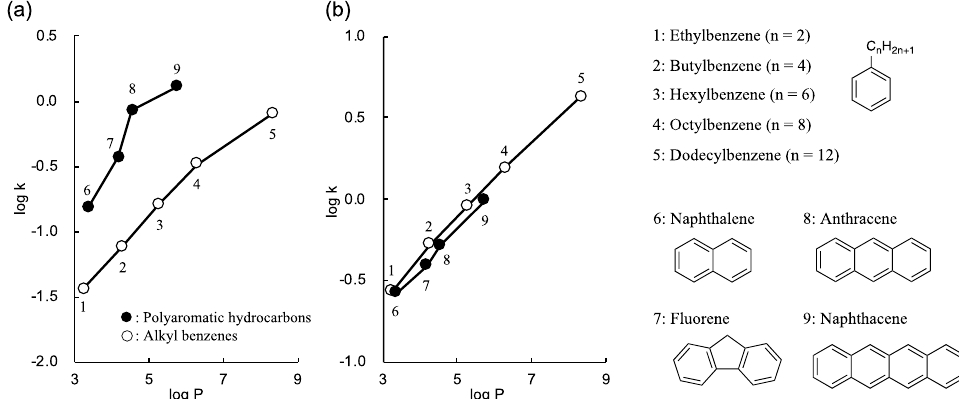
Figure 4. Relationships of log k and log P for ( a ) Sil−VP G 15 and ( b ) ODS. Mobile phase: Acetonitrile. Flow rate: 1.0 mL min −1 . Detection wavelength: 254 nm. Column temp.: 25 °C.